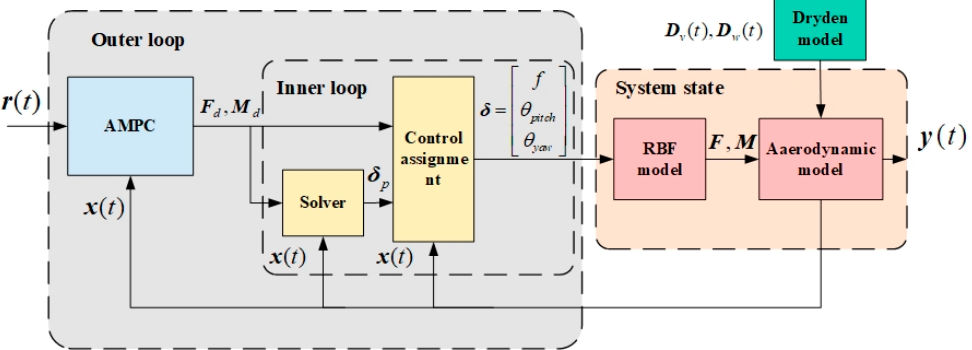
Figure 5. Schematic diagram of the RAMPC model.